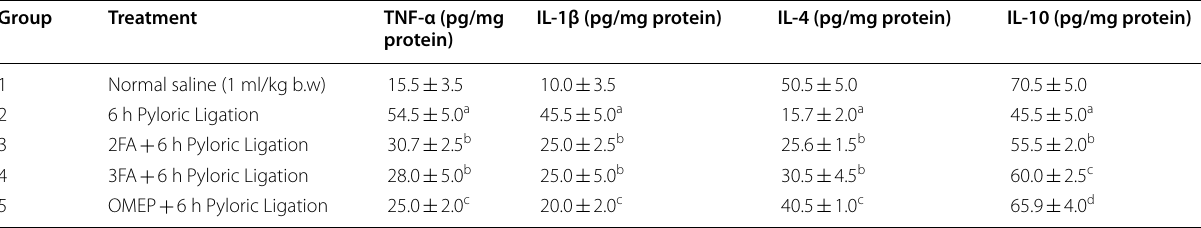
Table 4 Effect of varying doses of folic acid on pyloric ligation induced gastric ulcer: pro-inflammatory and anti-inflammatory